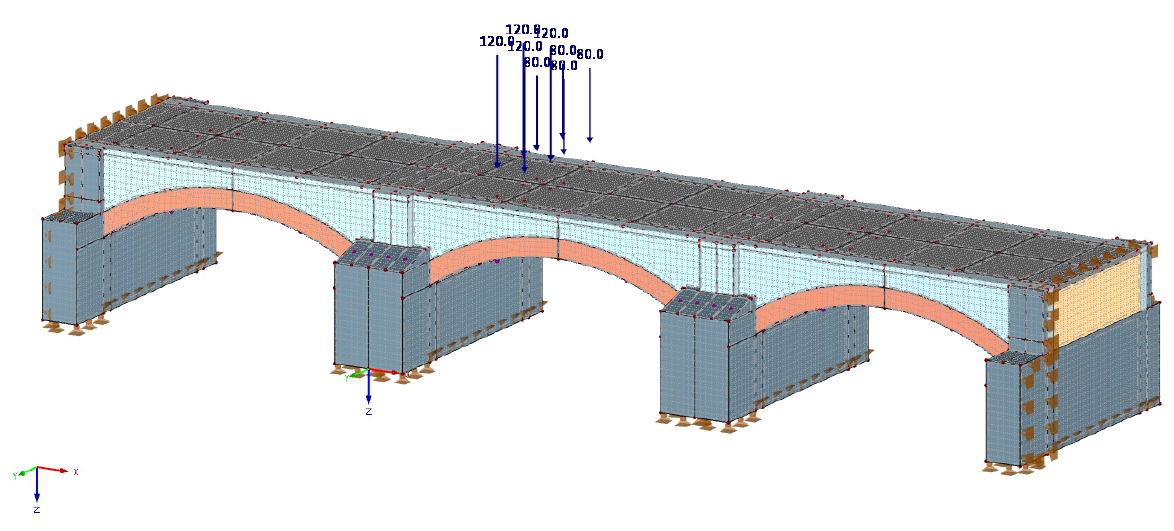
Figure 4. Full 3D bridge model with two tandem axle